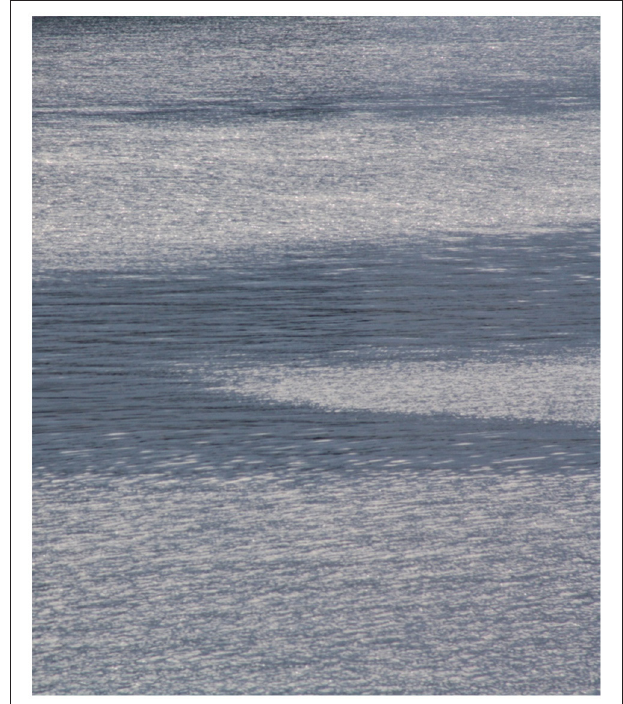
FIGURE 2 | Surface slicks attenuate small and capillary waves in the upper cm of the ocean, which causes a significant reduction of the glittering effect of sun beams. Photo by: Angela